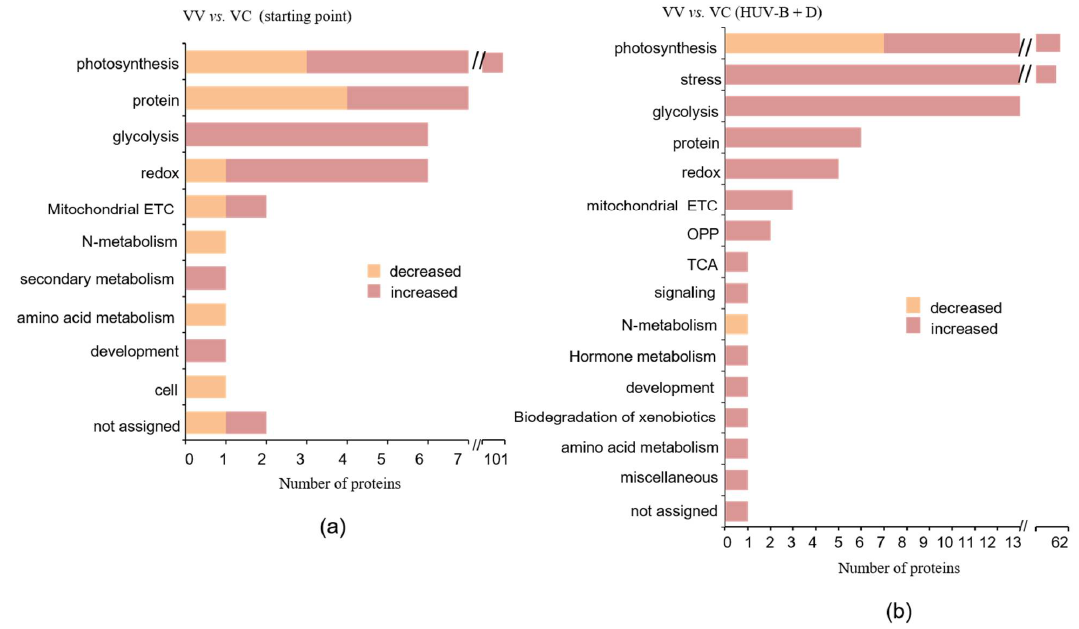
Figure 2. ( a , b ) Functional distribution of proteins identified in VIGS-vector and VIGS-CtPPO C.